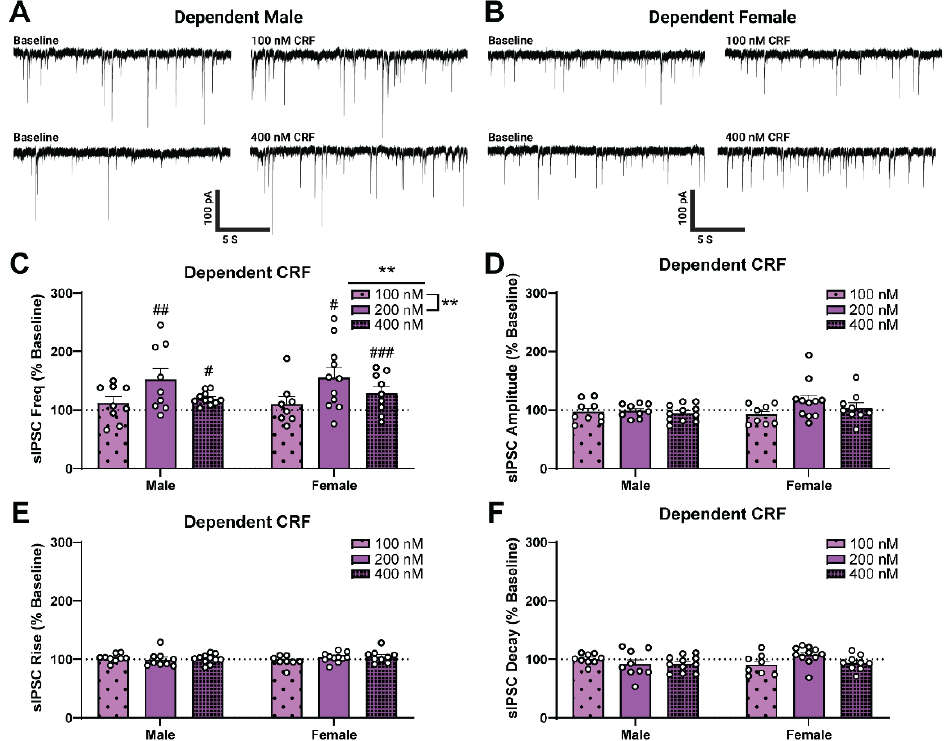
Figure 4. Alcohol dependence induces corticotropin releasing factor (CRF) responsivity of GABAergic synapses in female central amygdala (CeA). ( A , B ) Representative GABA A -mediated sIPSCs from CeA neurons of dependent male ( A ) and female ( B ) rats at baseline ( left ) and during acute application of 100 nM CRF ( right , upper ) or 400 nM CRF ( right , lower ). ( C – F ) Alcohol-dependent male and female sIPSC responses to varied CRF Concentrations. There is a main effect of CRF Concentration on sIPSC frequency ( C ), but no main effect of Sex and no interaction effect. There was no main effect of Sex or CRF Concentration and no interaction effect on sIPSC amplitude ( D ), rise time ( E ), or decay time ( F ). Changes from baseline sIPSC properties were assessed using one-sample t -tests where # denotes p < 0.05, ## denotes p < 0.01 and ### denotes p < 0.001. Differences between male and female sIPSC properties in response to CRF Concentrations were assessed using two-way ANOVA test with a post-hoc Šídák’s correction for multiple comparisons where ** denotes p < 0.01. Bars represent Mean ± SEM; 200 nM responses are the same as in Figure 2; n = 8–11 neurons per group; N = 3–8 rats per group.